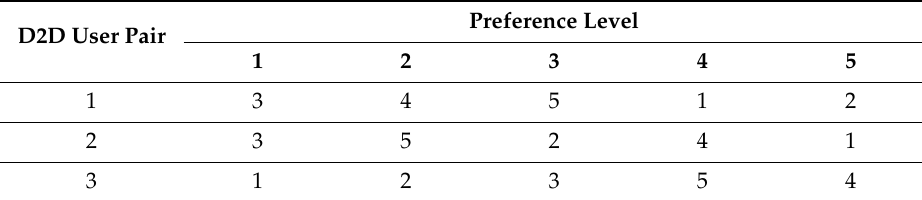
Table 1. D2D (device-to-device) user preference